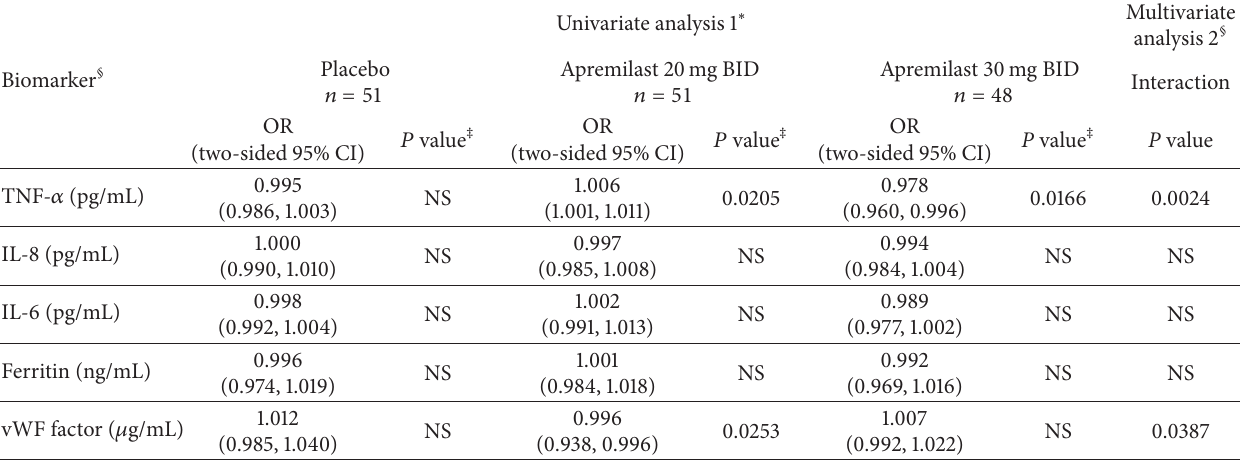
Table 2: Association between ACR20 response and biomarker change at Week 16.